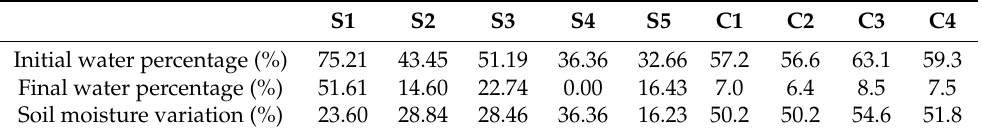
Table 6. Summary of the soil moisture